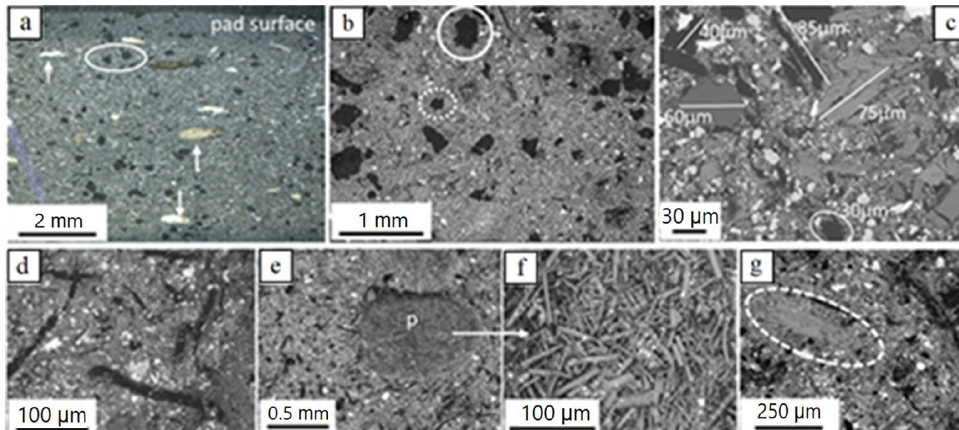
Figure 3. Light microscopy ( a ) and BSE-SEM ( b – g ) images of the new brake pad; ( a ): irregularly shaped carbon particles (black, example encircled) and fiber-rich pockets (examples pointed by arrows); ( b ): ‘very large’ and ‘large’ irregular carbon particles (partly encircled with solid and dotted lines, respectively) in finer matrix; ( c ): various ‘large’ particles in finer matrix; ( d ): hair-like carbon particles (black) in finer matrix ( e ): fiber-rich pocket ( p ) and magnification in ( f ) with well visible fibers; ( g ) sheet-forming, elongate ‘large’ particle (grey encircled; K-titanate) in finer matrix. Brightness of images increases with element atomic number. Samples in ( c ) and ( g ): impregnated/polished, all others untreated; ( a ) side view (pad profile), all others top view (pad surface). The brake pad matrix consists of particles with sizes predominantly in the fine- and the lower fraction of the coarse-scale (a few µm). These include hair-like carbon particles, individual fibers such as to those encountered in the fiber-rich pockets, as well as particles with irregular, sheet-forming (platy) and prismatic shapes (Figure 4a–c). Rarely, nearly spherical particles of fine- but also ultrafine-scales were recognized (Figure 4b,d). Ultrafine particle sizes were rarely detected either because the ultrafine material is highly compacted, thus hampering detection of single particles, or such sizes were not (or sparsely) included in pad construction.